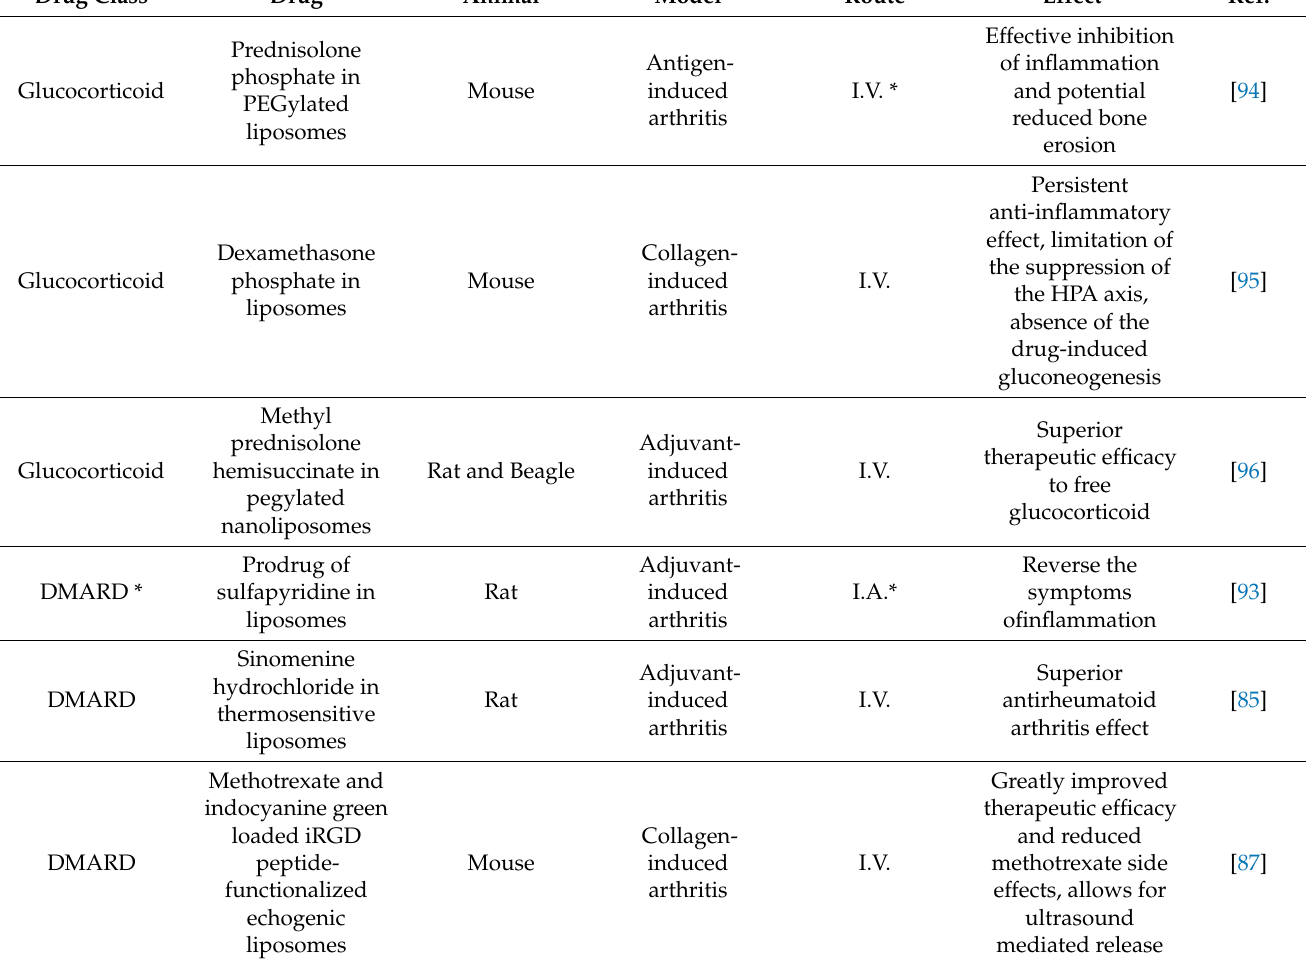
Table 1. Overview of innovative research using liposome-based drug delivery in the treatment of RA. Drug Class Drug Animal Model Route Effect *